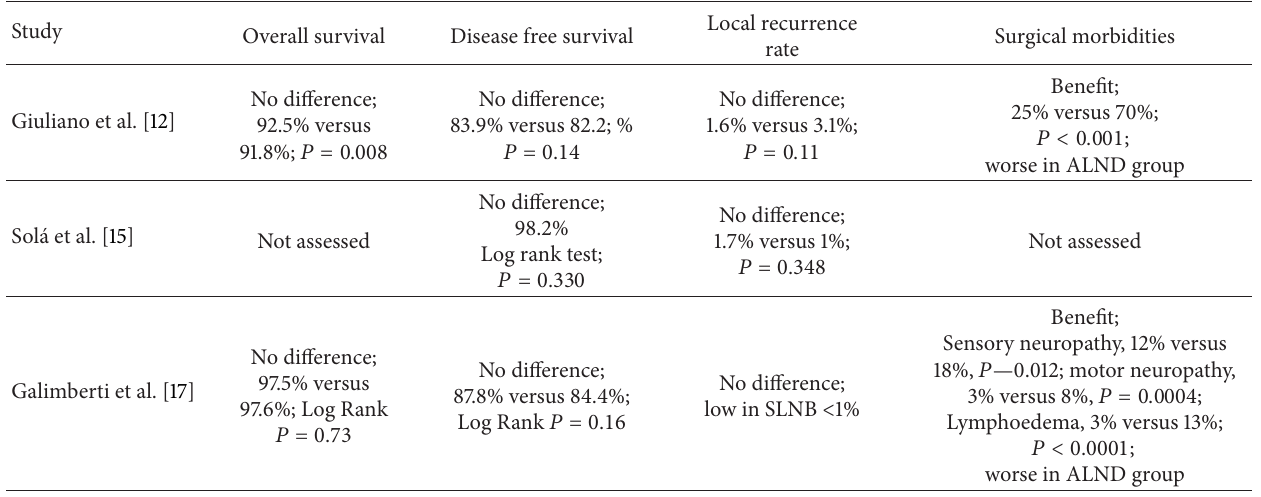
Table 3: Summary of differences in outcomes of SLND alone versus